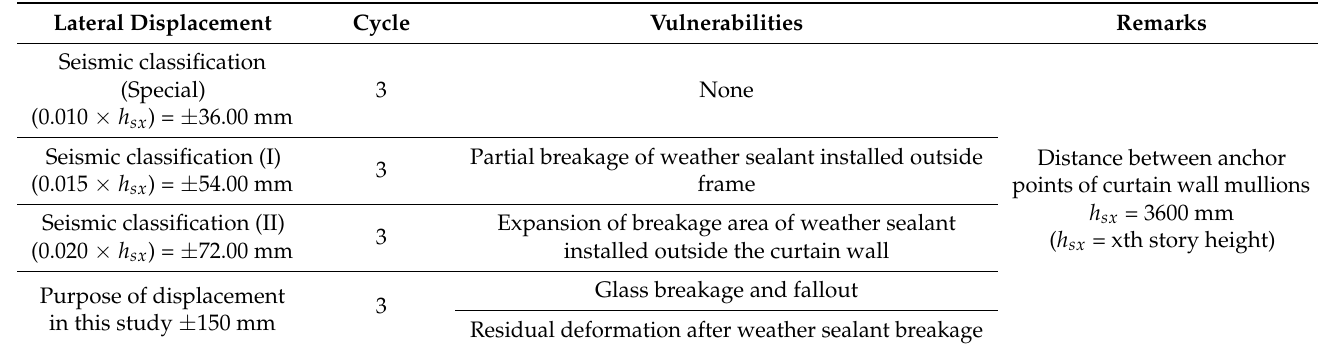
Figure 4. Main vulnerabilities of non-seismic curtain wall: ( a ) external weather sealant breakage; ( b ) glass fallout; ( c ) curtain wall frame breakage; ( d ) expansion joint breakage. Table 3. Summary of seismic performance evaluation results.